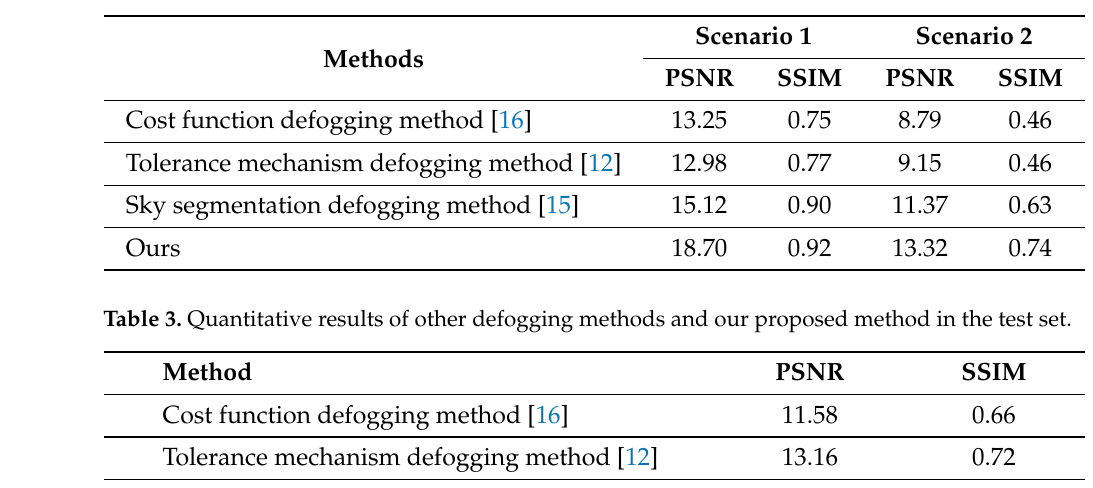
Table 2. Quantitative results of other defogging methods and our proposed method in the images of Figure 7.